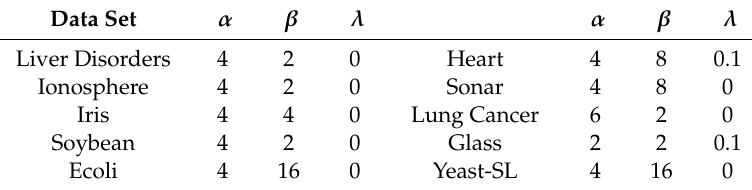
Table 6. Pre-defined constants for RBF-ISCC for single-label data sets.